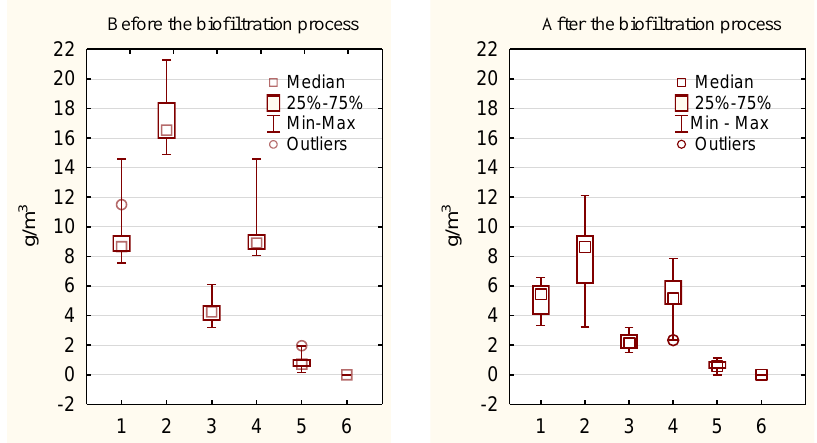
Figure 9. Statistical analysis of selected physicochemical results obtained for water before and after the biofiltration process on granular activated carbon deposits. Designations: (1) TOC (g C/m 3 ); (2) UV absorbance (UV 1m254 ); (3) Permanganate value (g O 2 /m 3 ); (4) Dissolved oxygen (g O 2 /m 3 ); (5) Total inorganic nitrogen (g N norg /m 3 ); (6) Total phosphorus (g PO 43– /m 3 ); (N = 44).